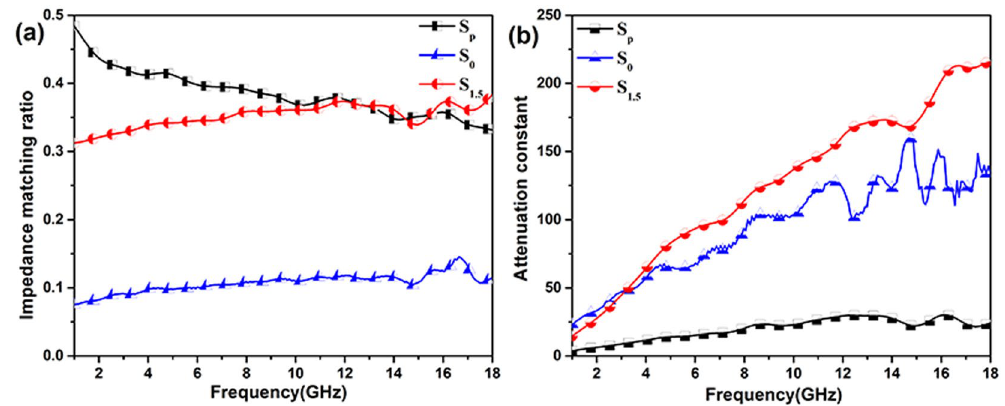
Figure 6. ( a ) Impedance matching ratio Z , ( b ) attenuation constant α of S p , S 0 and S 1.5